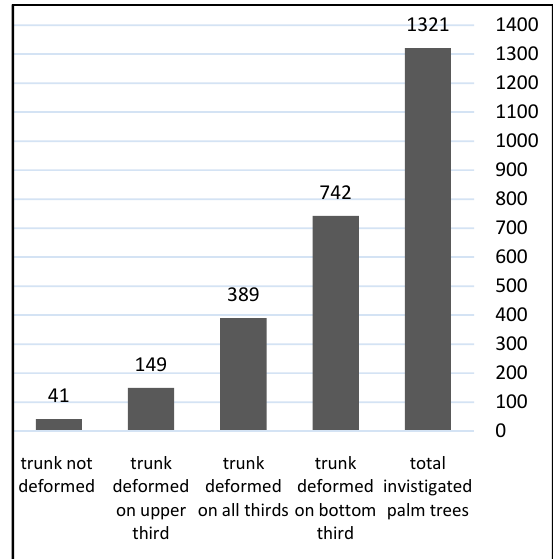
Source: compiled by author *total includes 41 unaffected trees; ** percentages of trees with deformation along different thirds of the trunk in each segment; and *** percentages based on the total of trees with deformed trunks in all segments of the DCS (1,280).